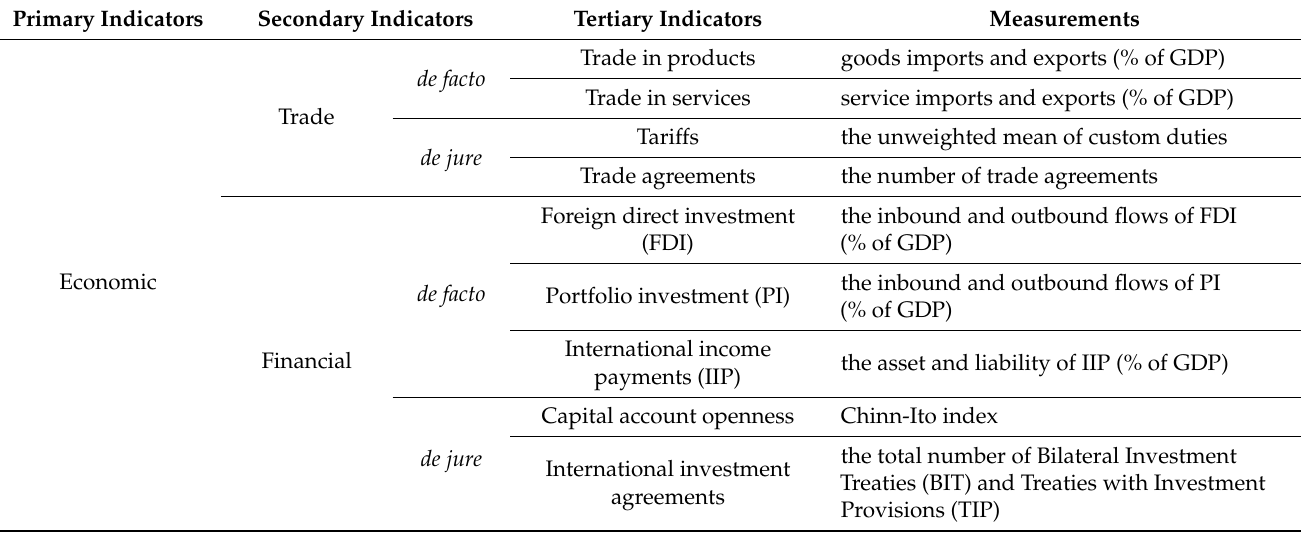
Table A1. Measurements of all indicators in the globalization